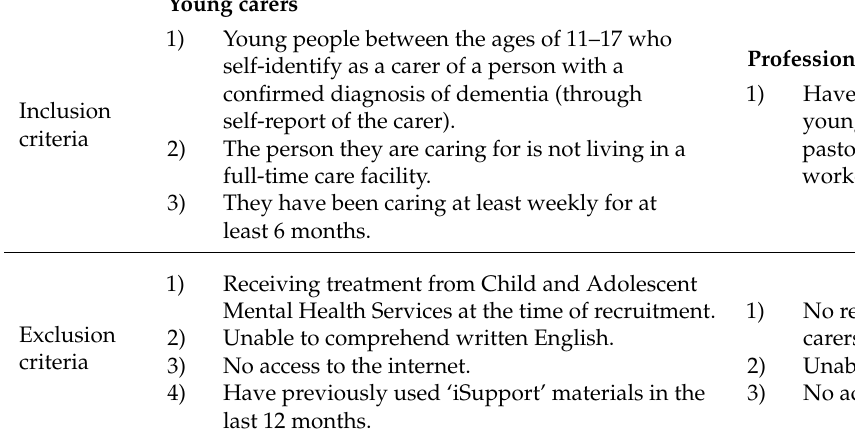
Table 1. Participant eligibility